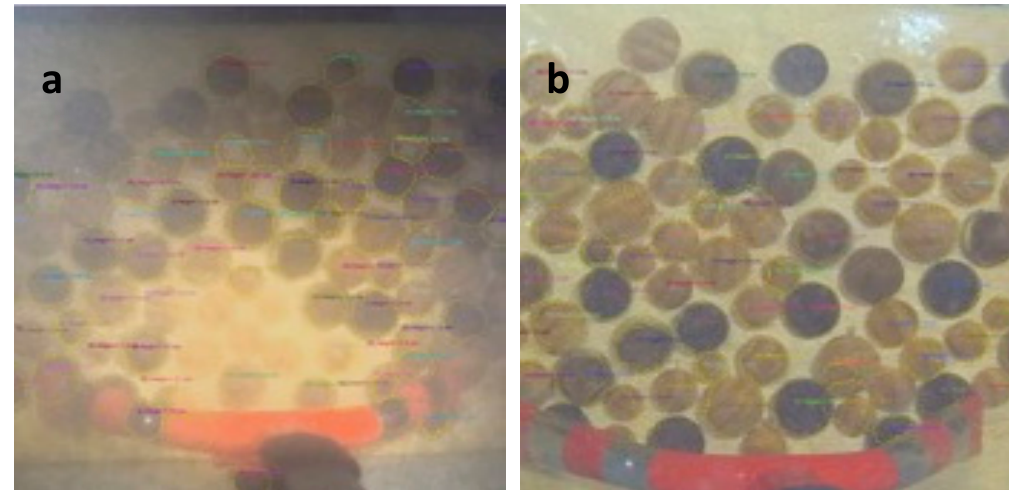
Figure 12. Reconstructed images in two conditions, flood light 58 cm ( a ) and spot light 65 cm ( b ).